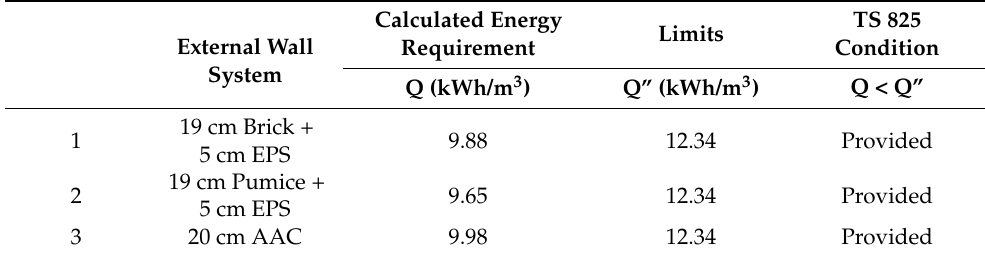
Table 5. The 1st climate